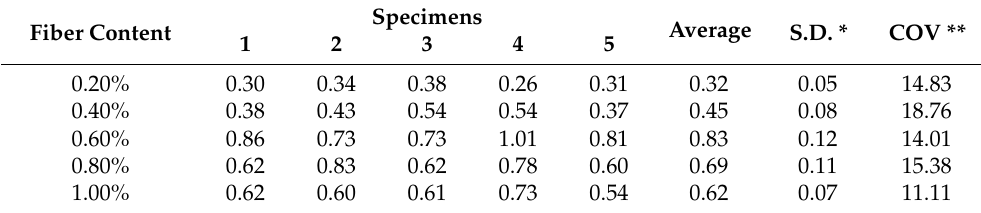
Table 7. Residual strength at L /600